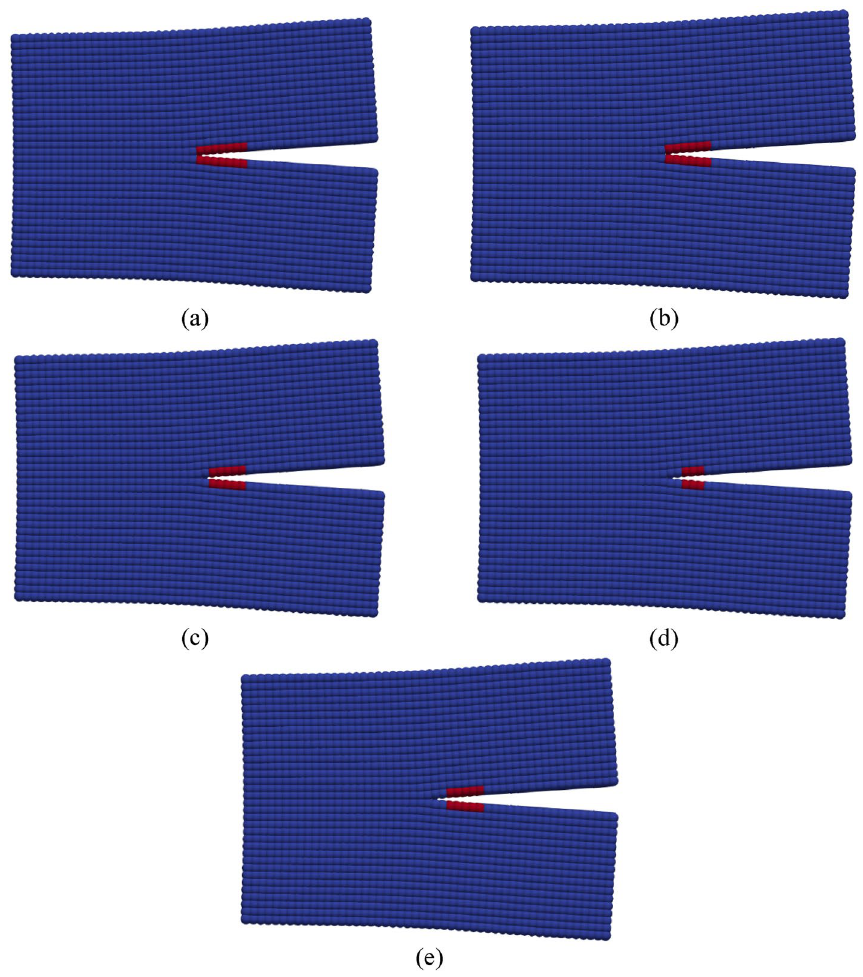
Figure 7. Crack propagation at 69.8 k cycles when ( a ) nodal damage value of 0.3, ( b ) nodal damage value of 0.35, ( c ) nodal damage value of 0.4, ( d ) nodal damage value of 0.45, ( e ) the crack on mid-plane method. Displacements are magnified by